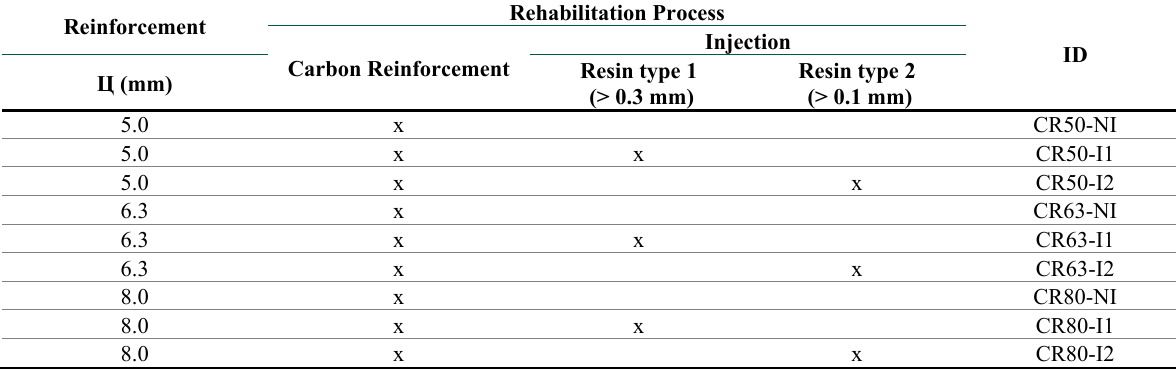
Table 2. Specimen IDs according to structural rehabilitation process. Reinforcement